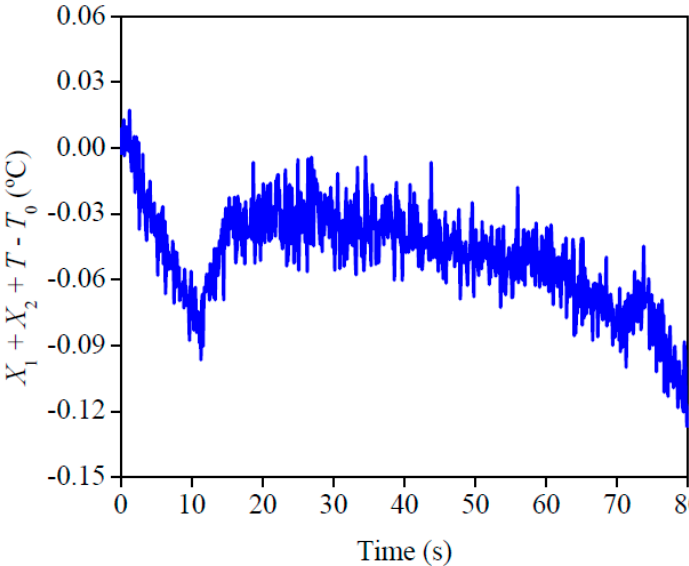
Figure 5. Results of the ideal condition and design for the experiment on AISI 1045.